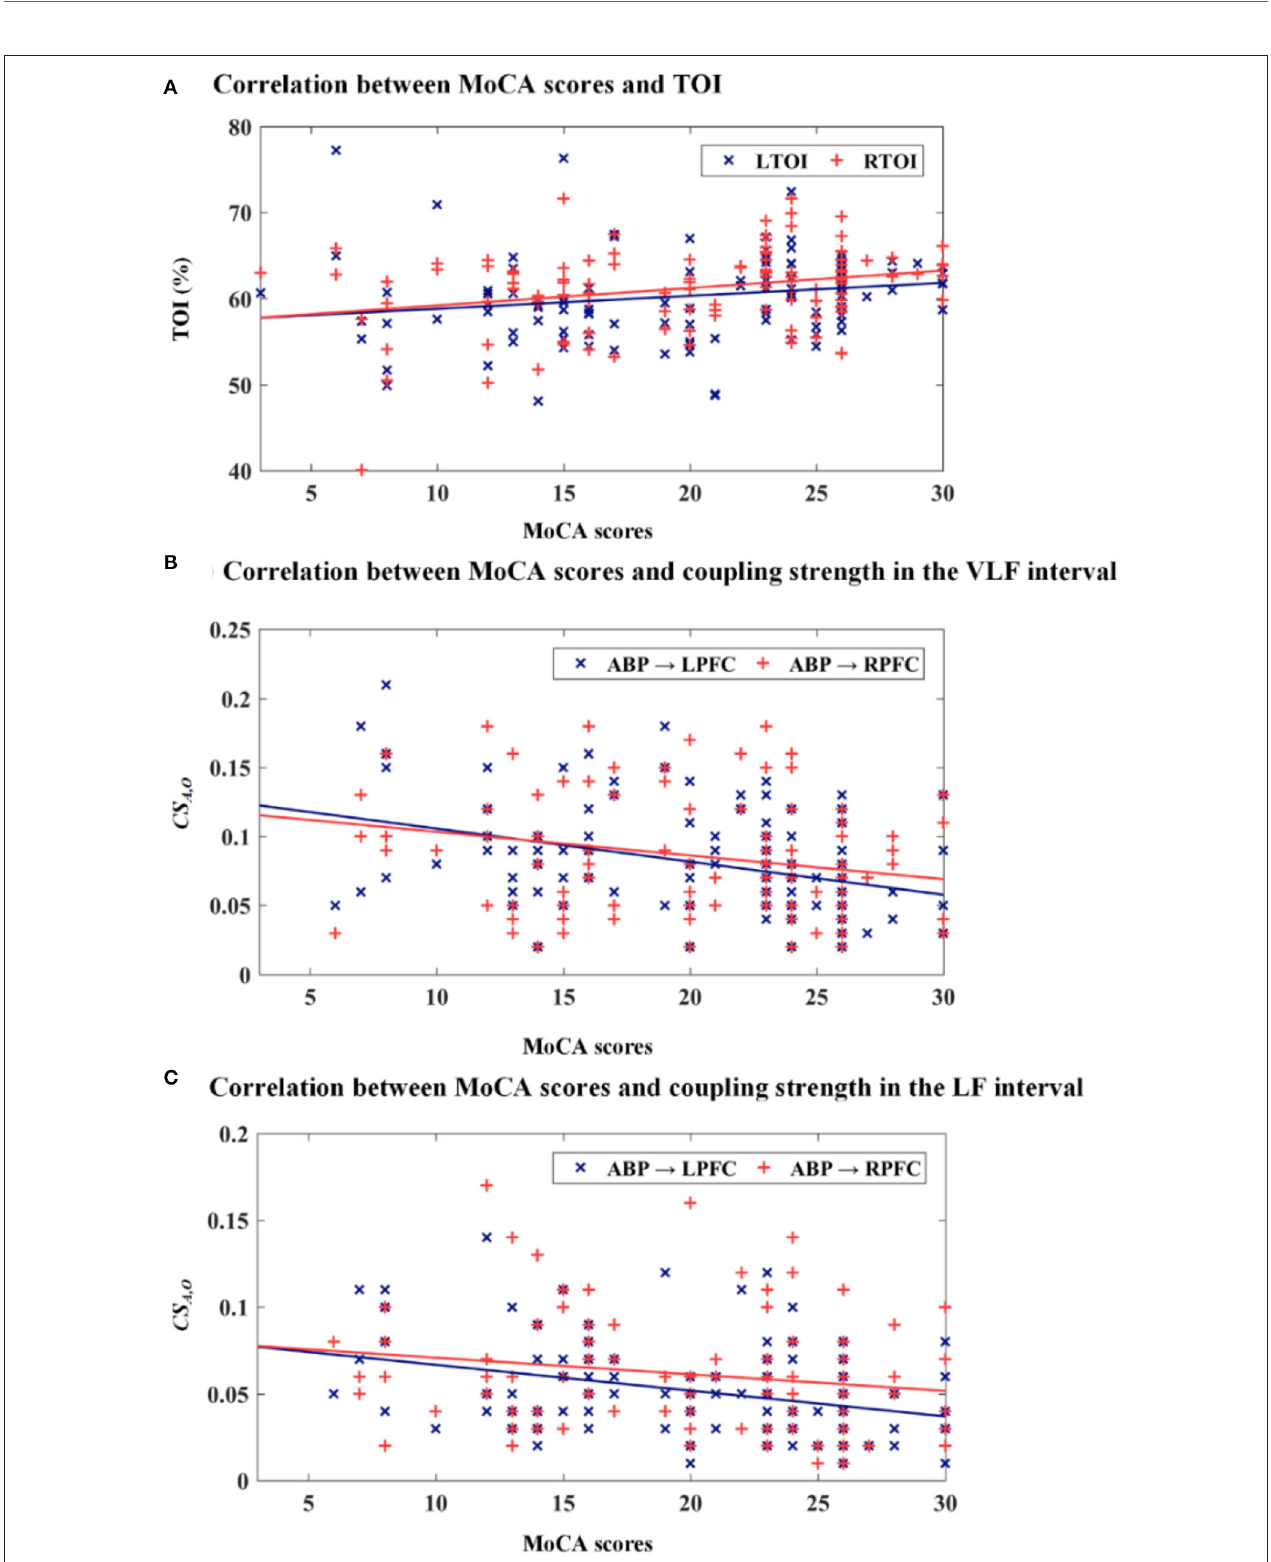
FIGURE 5 | Scatterplots of TOI vs. MoCA scores and coupling strength vs. MoCA scores. (A) MoCA scores vs. TOI, (B) MoCA scores vs. CS A , O in the VLF interval, and (C) MoCA scores vs. CS A , O in the LF interval.